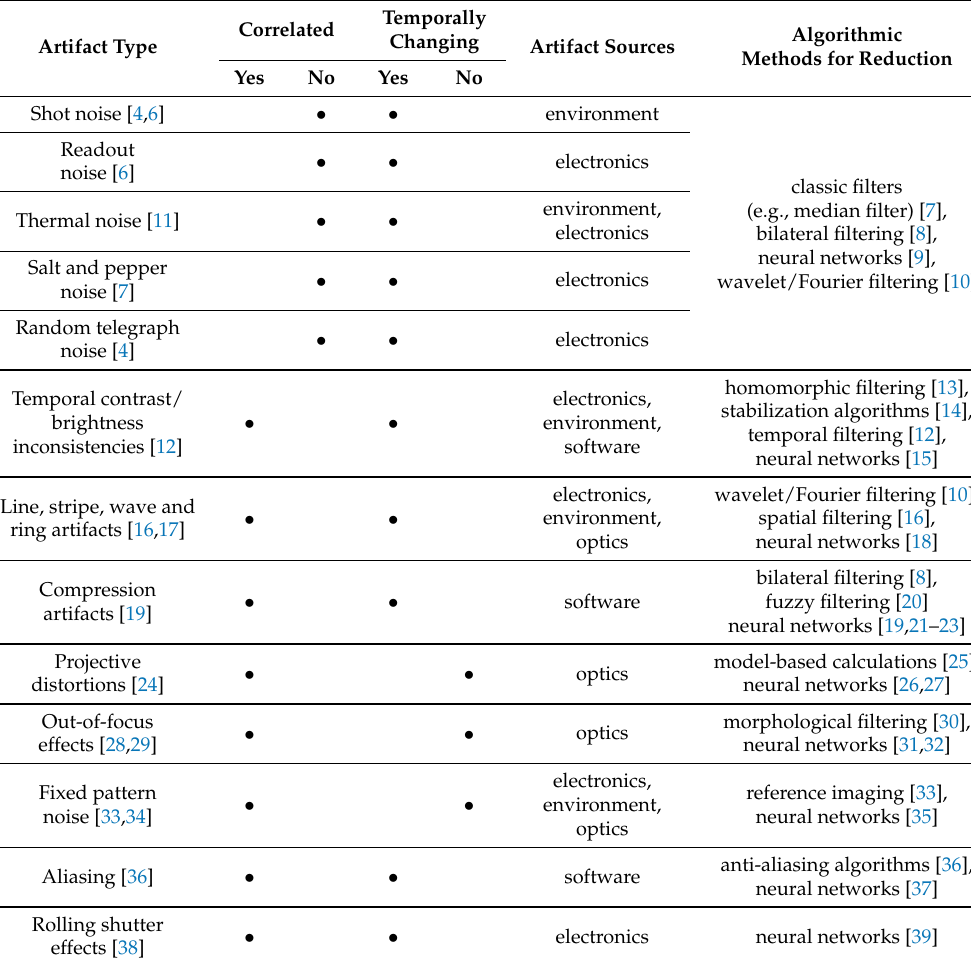
Table 1. Overview of common artifact types in sensor images, their properties, sources, and exam- ples for algorithmic reduction methods. Correlated artifacts are also called structured noise, and uncorrelated artifacts are called unstructured. Temporally changing artifacts can vary in each